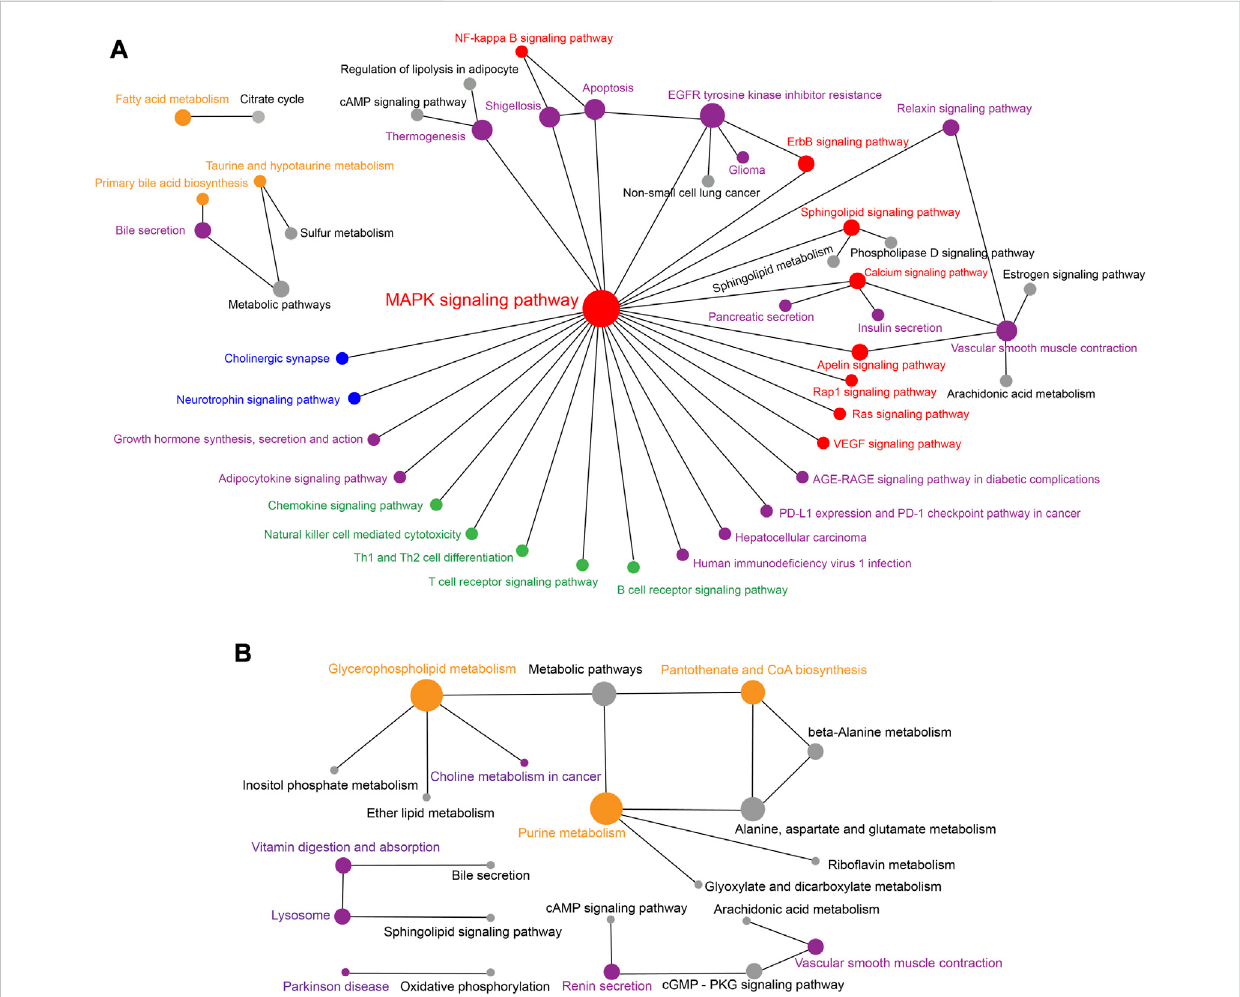
FIGURE 7 Network relationships of the KEGG pathways signi fi cantly associated with the signi fi cantly abundant metabolites in the cochlea of R. sinicus (A) and V. sinensis (B) , respectively. The size of the dot indicates the level of connectivity of a speci fi c pathway interacting with others. Signi fi cantly